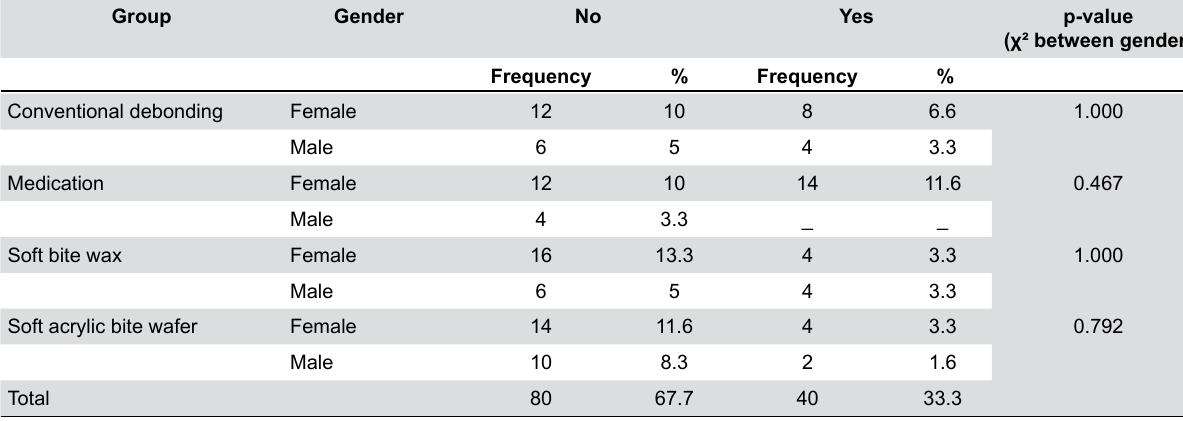
Table 1- Distribution of the anxiety scores and their between-groups and between genders comparisons